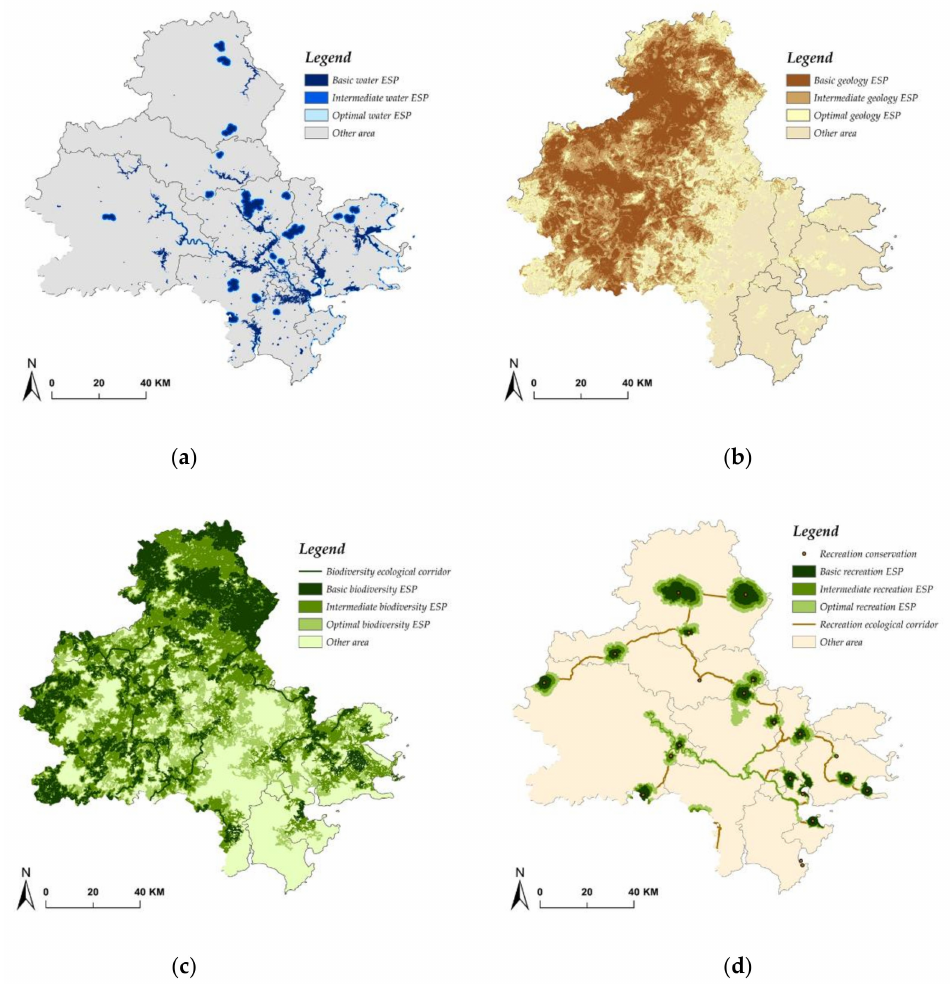
Figure 3. ( a ) Water ESP; ( b ) Geology ESP; ( c ) Biodiversity ESP; ( d ) Recreation